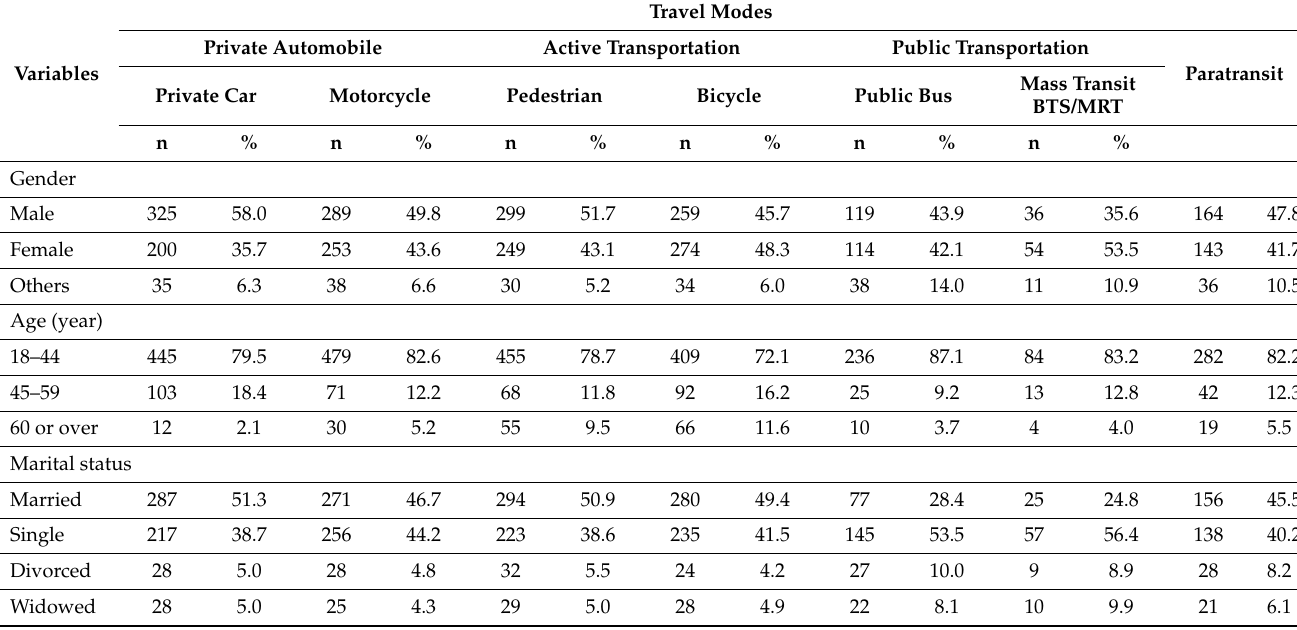
Table 1. Respondents’ social